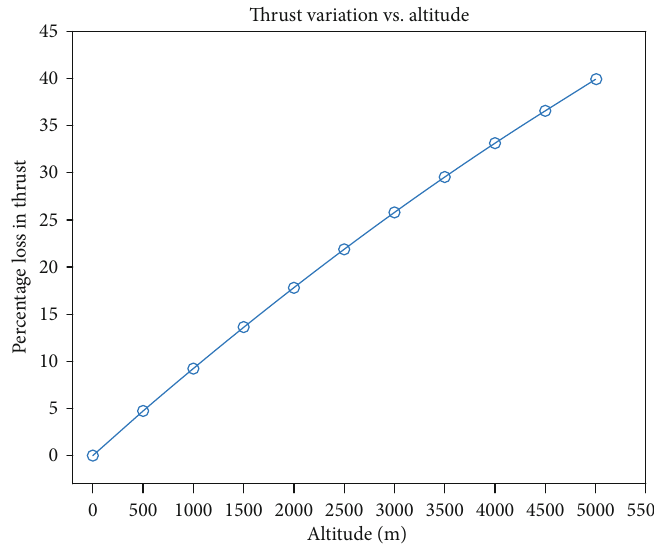
Figure 1: Percentage loss of thrust vs.